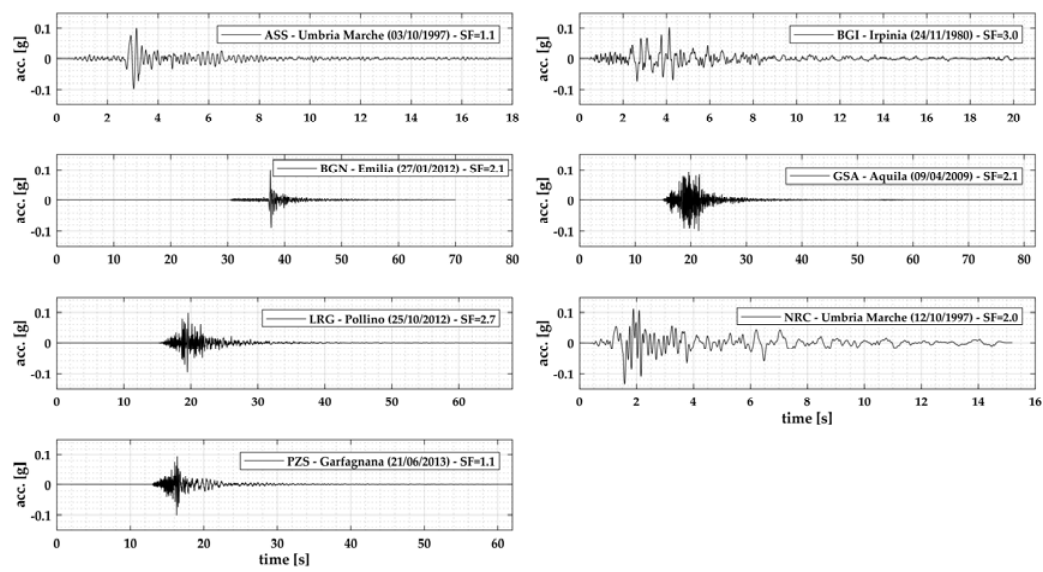
Figure 6. Time histories of the scaled accelerograms for an RP of 130 years.